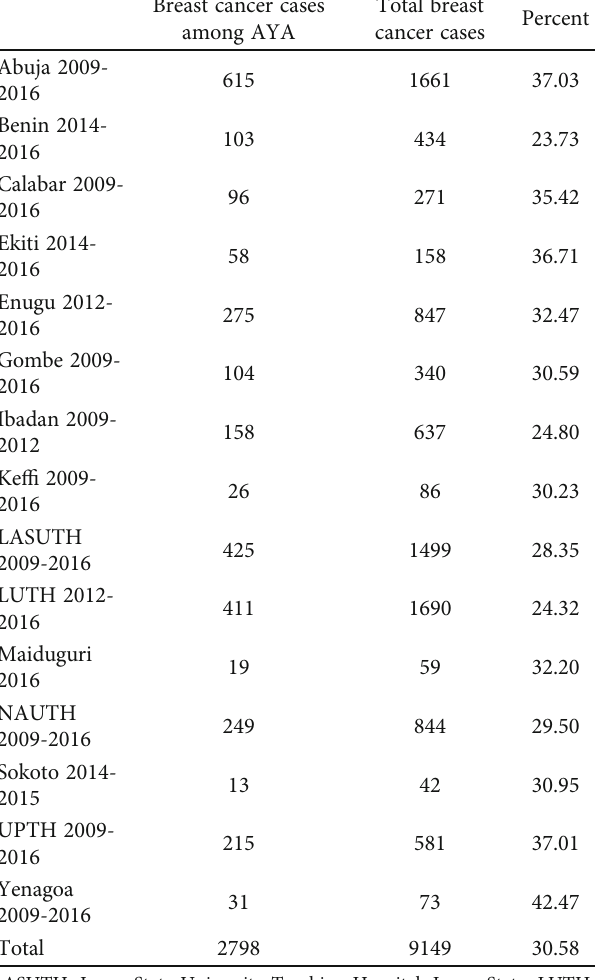
Table 4: Comparison of breast cancer incidence among female adolescents and young adults between Northern and Southern states of